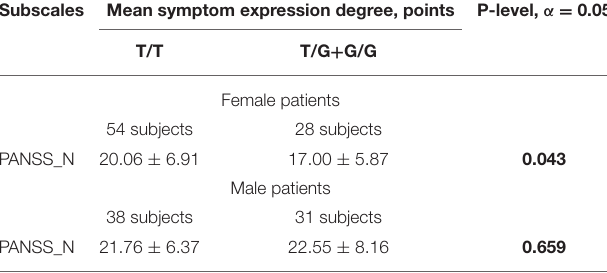
Values are represented as Mean ± SD. Bold values indicate the mean statistical significance or %